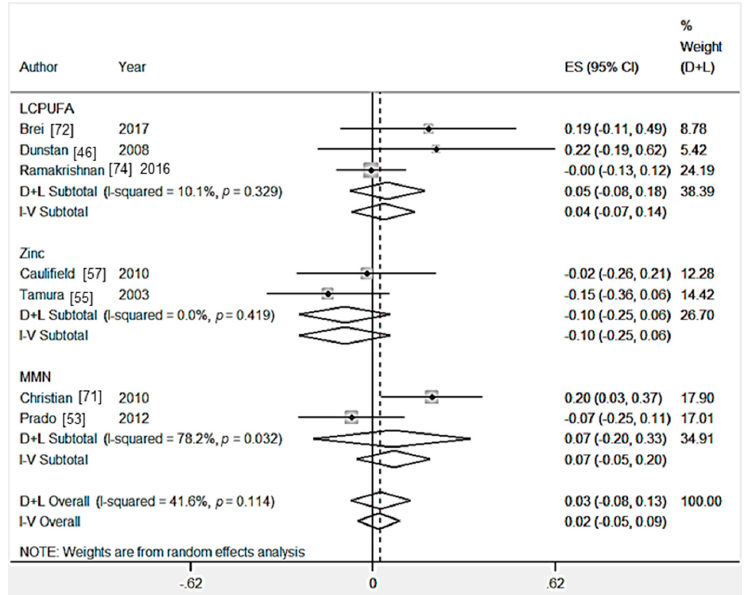
Figure 4. Forest plot for child fluid intelligence outcomes. The overall effect size was estimated by standardised mean difference (SMD). LCPUFA, long chain polyunsaturated fatty acids; MMN, multiple micronutrient. D+L, random-effects estimate (Der Simonian and Laird method) and I-V, fixed-effects estimate (inverse variance method).